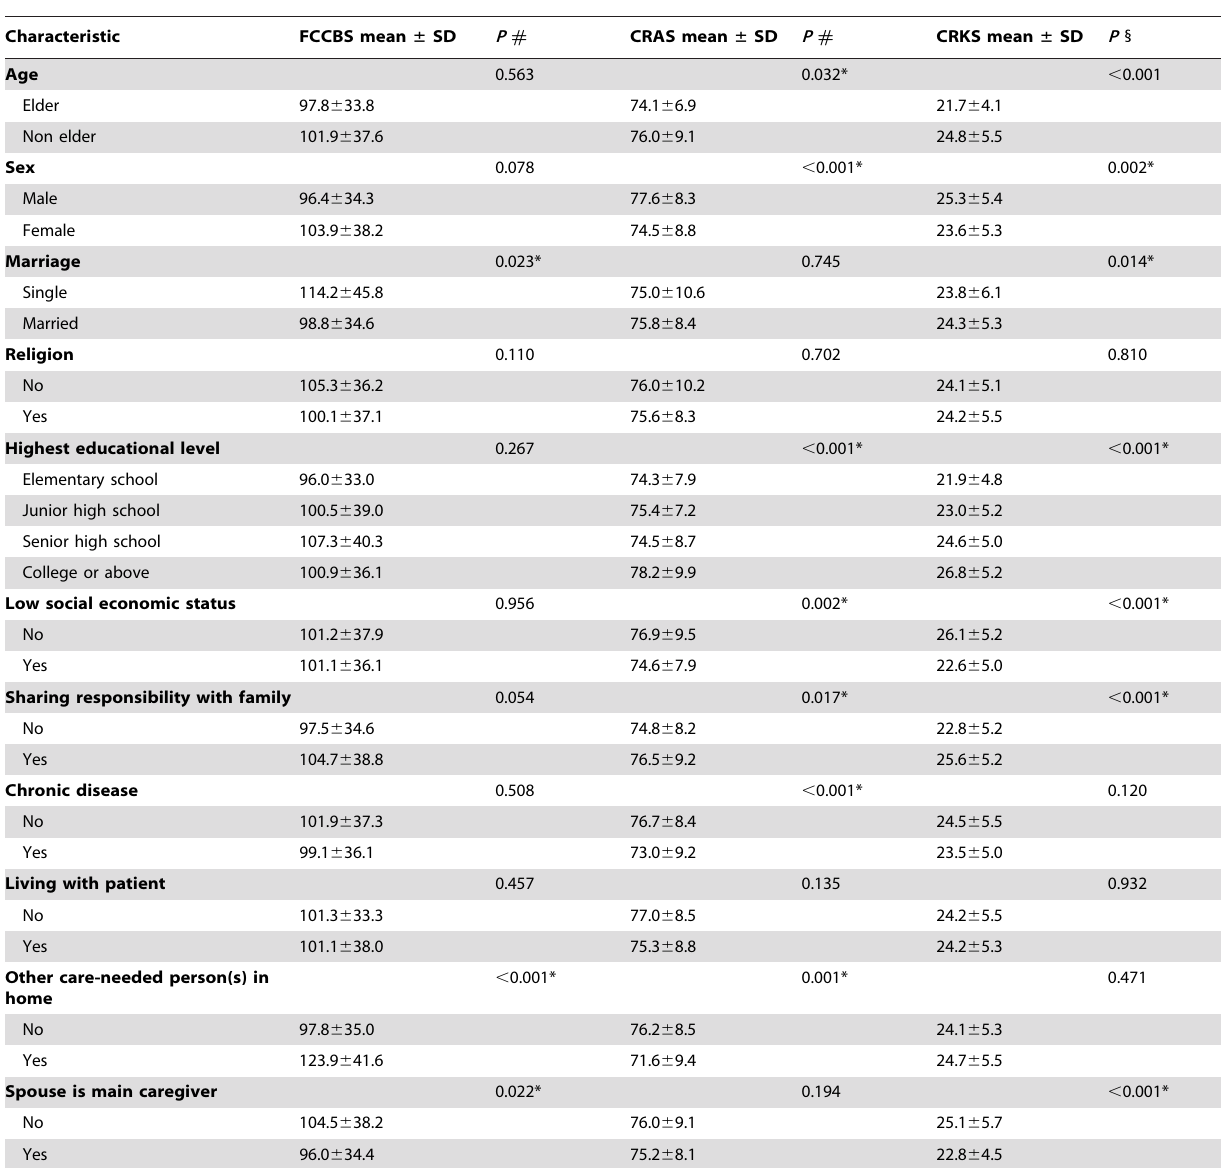
Table 3. Comparison of CRKS, FCCBS, CRAS between different categorical